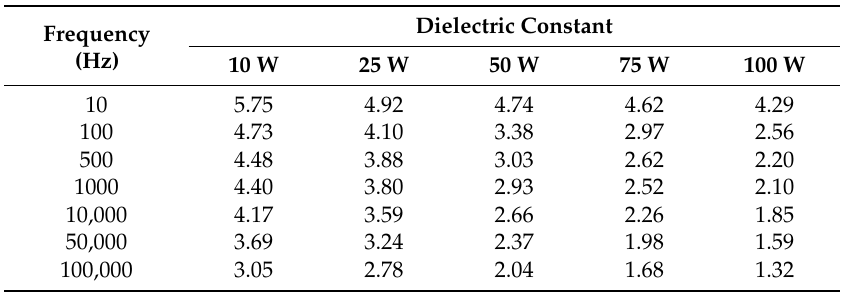
Figure 4. Capacitance of plasma-polymerised pelargonium thin films fabricated at different deposition power as a function of frequency in the range of 10–100 kHz. Table 1. Variation of the corresponding dielectric constants with frequency for pelargonium plasma polymer thin films in the range of 10–100 kHz.